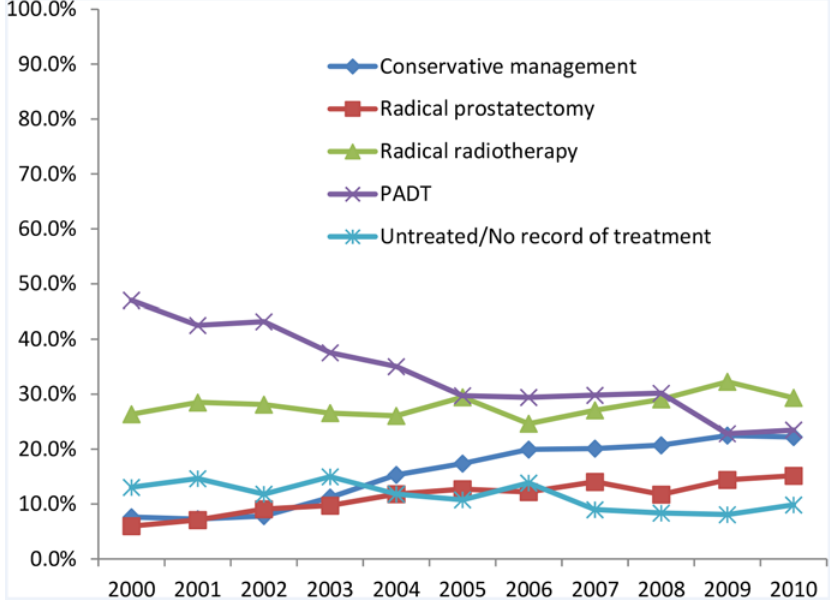
Fig 1. Proportions of men with non-metastatic cancer treated by different modalities in the Anglia Cancer Network from 2000 – 2010.